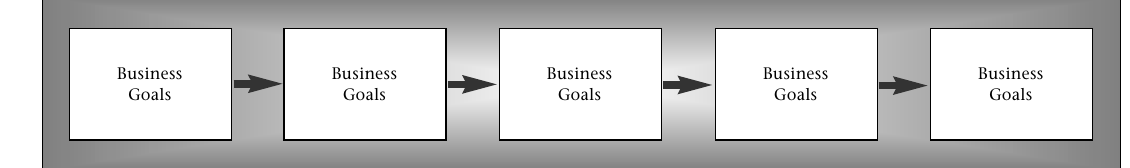
Figure 1: A model for linking business goals with individual and organisational performance (from Gratton, 2000,